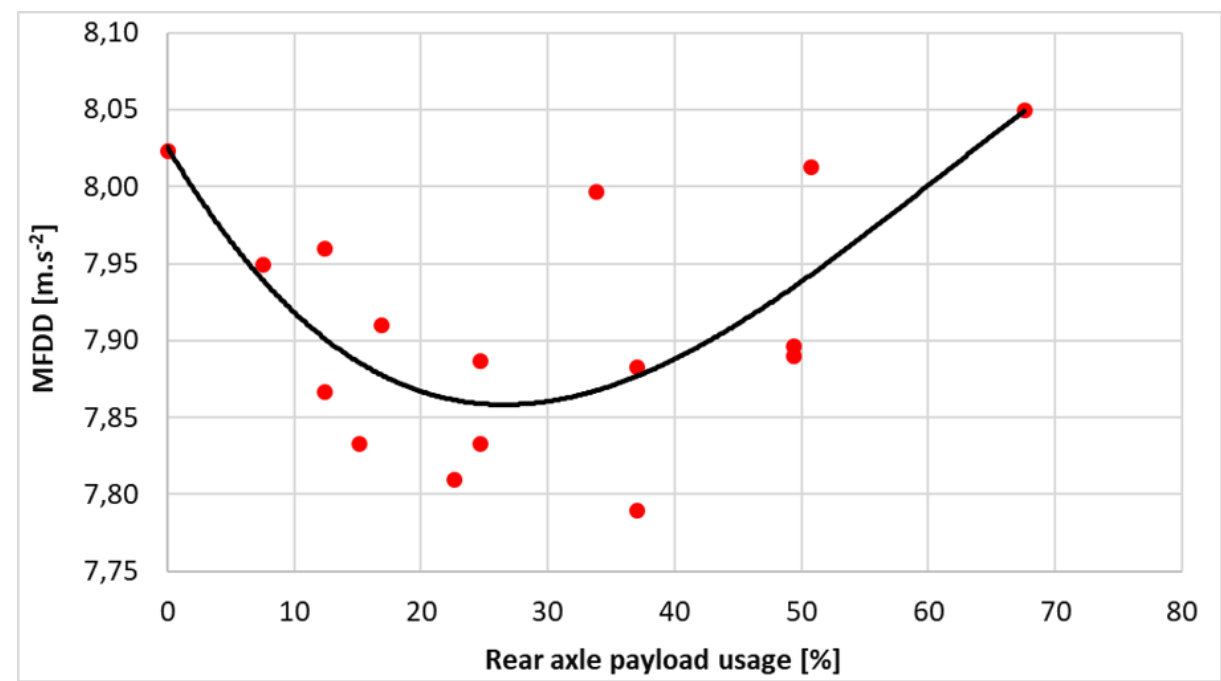
Figure 8: Dependence of the payload utilization rate of rear axle on the MFDD Source: